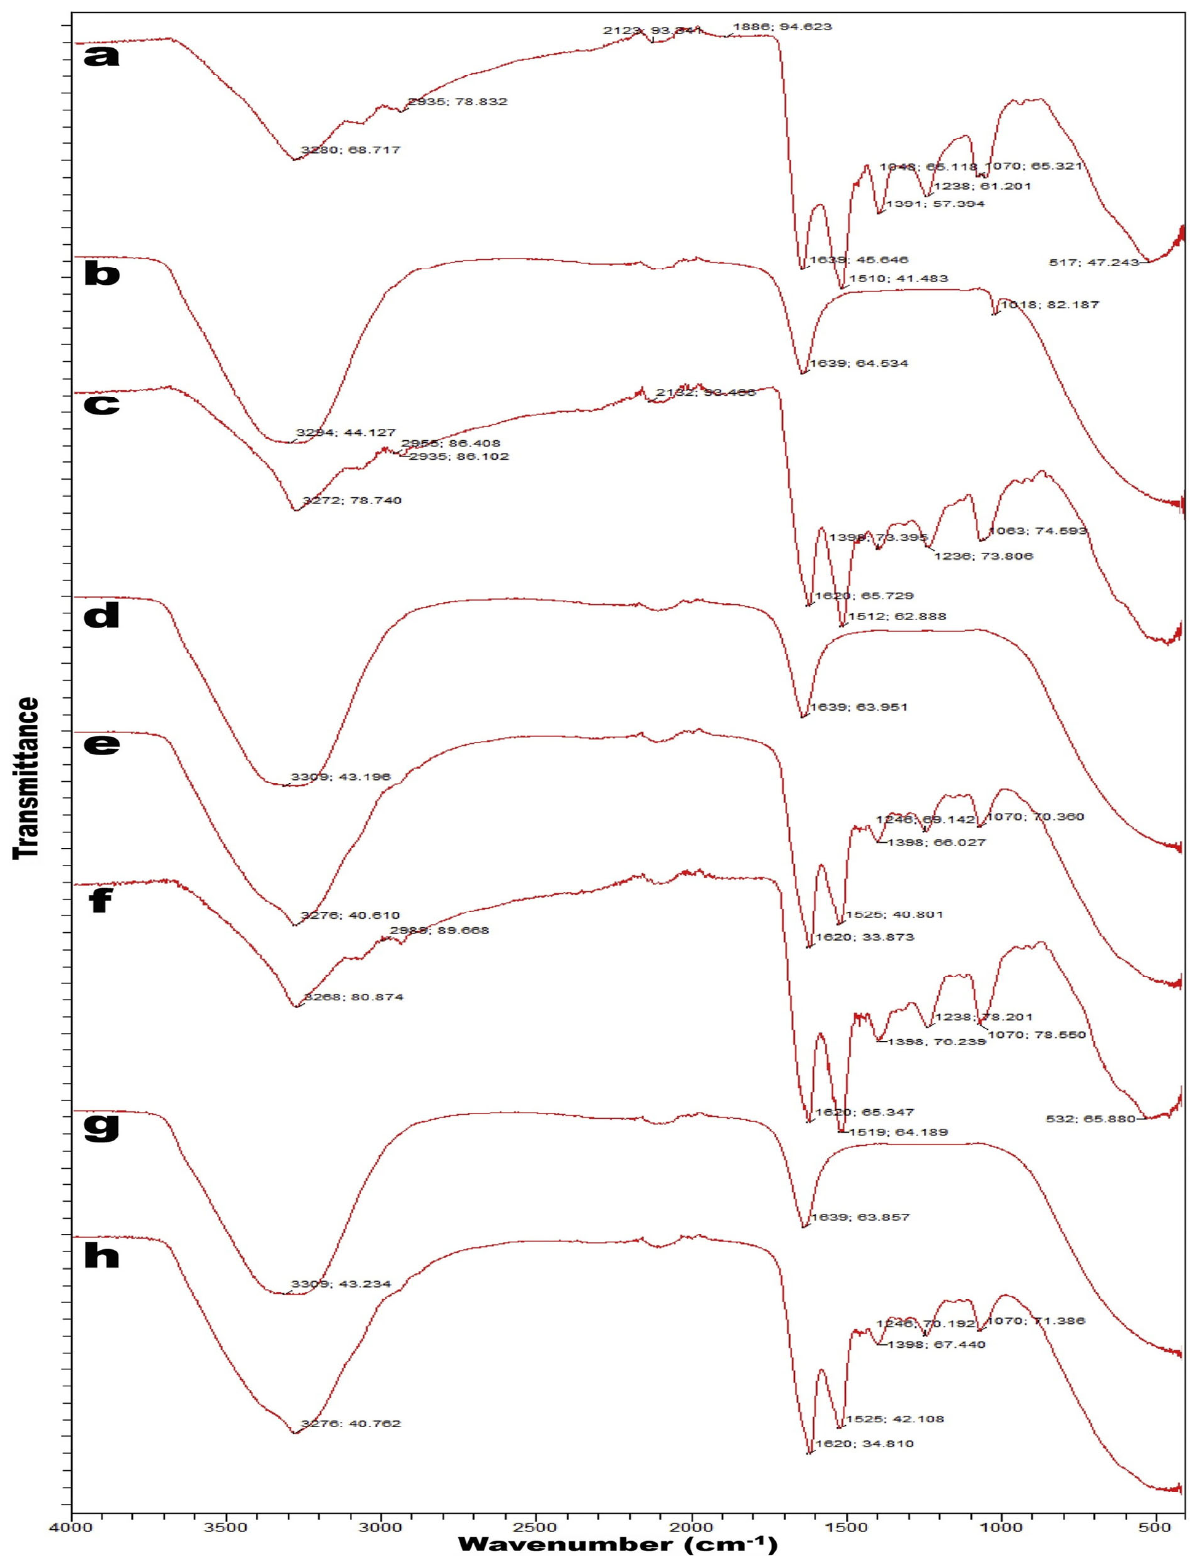
Figure 3. FTIR spectra of sericin: (a) sample in powder; (b) sample in solution; (c) sample in powder; (d) sample in powder aqueous supernatant; (e) sample in powder aqueous pellet; (f) sample in powder; (g) sample in powder aqueous supernatant; and (h) sample in powder aqueous pellet. Reproduced with permission from Rocha et al. [44], 2017, Elsevier (originally Figure